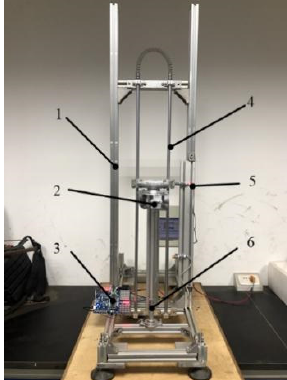
Figure 13. Mechanical claw shell breaking test bench. (1) Frame; (2) Three-fingered mechanical claws; (3) Microcontroller; (4) Sliding rail; (5) Proximity switch; (6) Impact table.